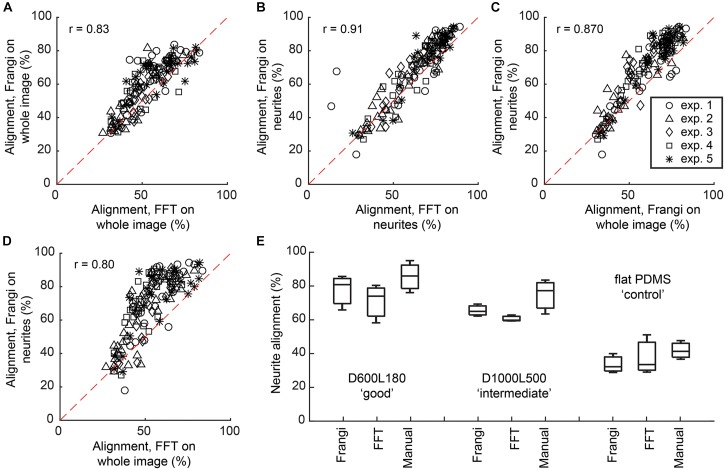
Comparison between Frangi vesselness, FFT, and manual neurite assessment. (A) Scatter plot showing the comparison between calculating alignment of neuronal cell culture to the underlying nanogrooved pattern by means of FFT and Frangi vesselness. Spearman’s non-parametric correlation coefficient was calculated using a two-tailed P-value and 99% confidence interval, resulting in r = 0.83 with P < 0.0001. (B) Scatter plot showing the comparison between calculating alignment of neurites to the underlying nanogrooved pattern by means of FFT and Frangi vesselness applied to a neurite-only image, resulting in r = 0.91 with P < 0.0001. (C) Scatter plot showing the comparison between calculating alignment of neurites to the underlying nanogrooved pattern by means of Frangi vesselness applied to a whole image versus applied to a neurite-only image, resulting in r = 0.87 with P < 0.0001. (D) Scatter plot showing the comparison between calculating alignment of neurites to the underlying nanogrooved pattern by means of FFT applied to a whole image versus Frangi vesselness applied to a neurite-only image, resulting in r = 0.80 with P < 0.0001. The legend in (C) shows markers for data of each experiment for plots (A–D). (E) Comparison of neurite alignment as measured through Frangi vesselness, FFT, and manual neurite assessment. The comparison is made for n = 3 samples of pattern D600L180 for high alignment, pattern D1000L500 for intermediate alignment, and the flat PDMS substrate as a control. Box plots show median with interquartile range (IQR) and whiskers, with whiskers and median being the values found for neurite alignment for each of the different measurements on the three substrate types.